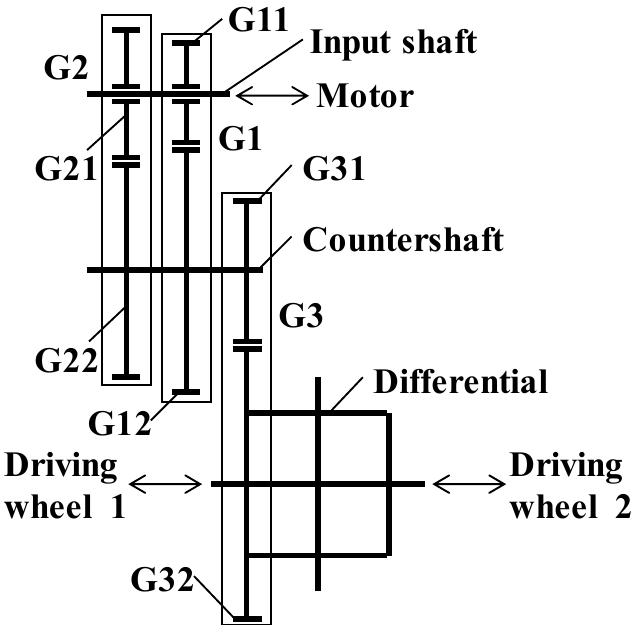
Figure 1. Gear train (GT) of the two-speed dedicated electric transmission (2DET).